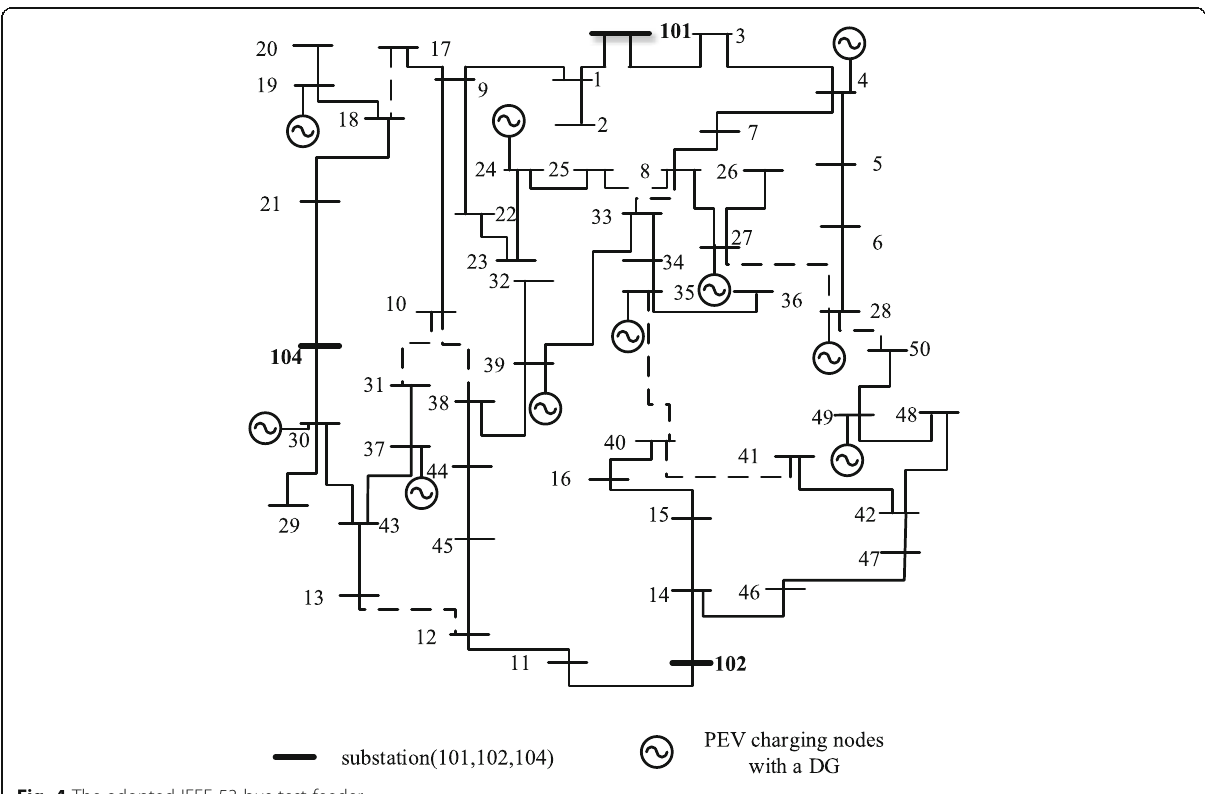
Fig. 4 The adopted IEEE 53-bus test feeder